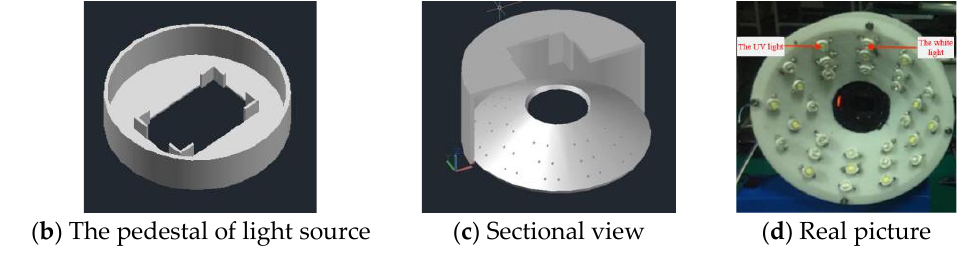
Figure 3. The structure of light source in this experiment.